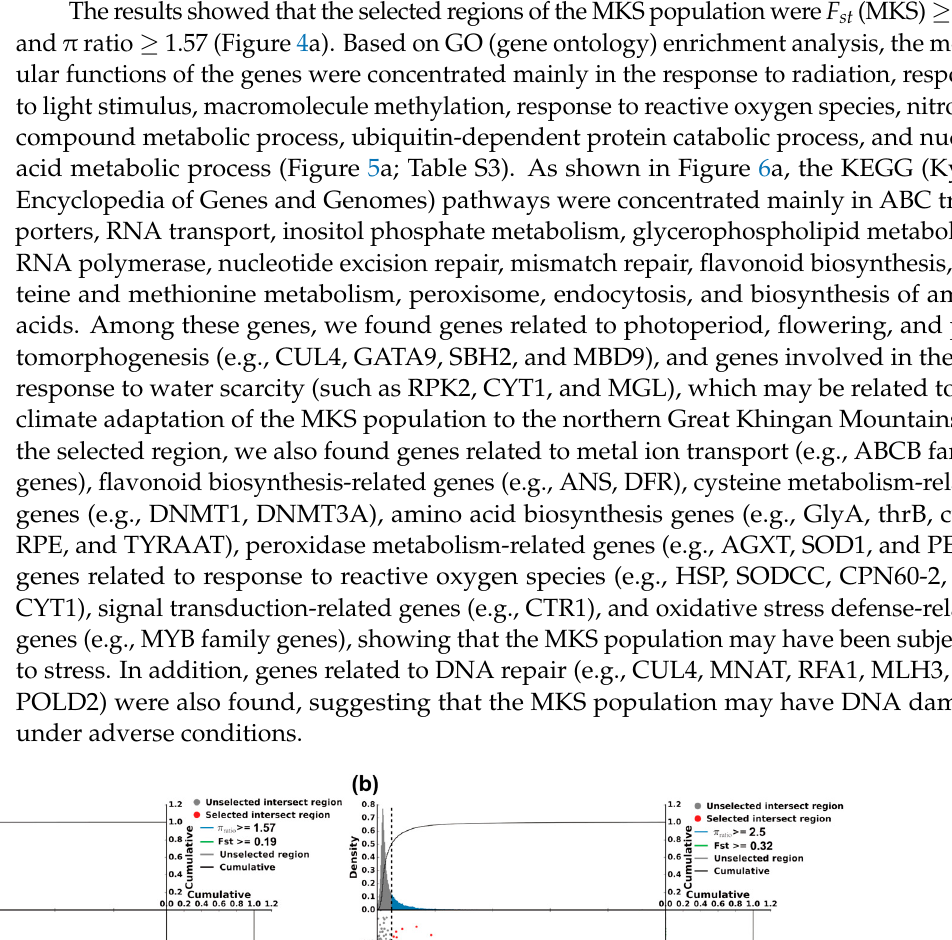
Figure 5. Annotation based on the GO database. The Y -axis indicates the top 30 GO terms, and the X -axis indicates the numbers of genes annotated to the terms and their P values: ( a ) MKS population; ( b ) WYL population.